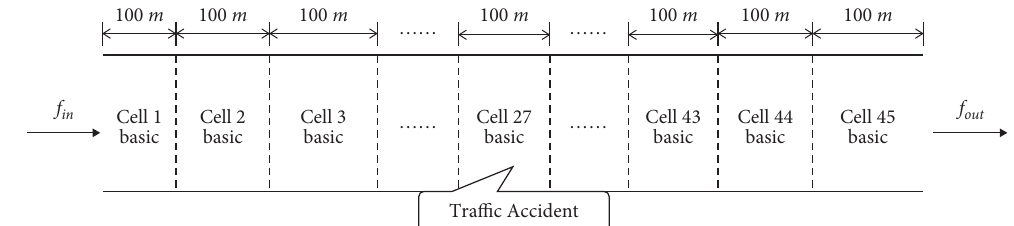
Figure 13: Mixed traffic flow simulation